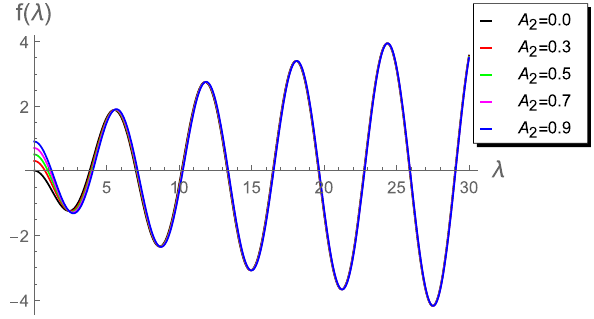
Figure 1. Plot of f ( (cid:31) ) vs (cid:31) for A 2 = { 0.0, 0.3, 0.5, 0.7, 0.9 } .